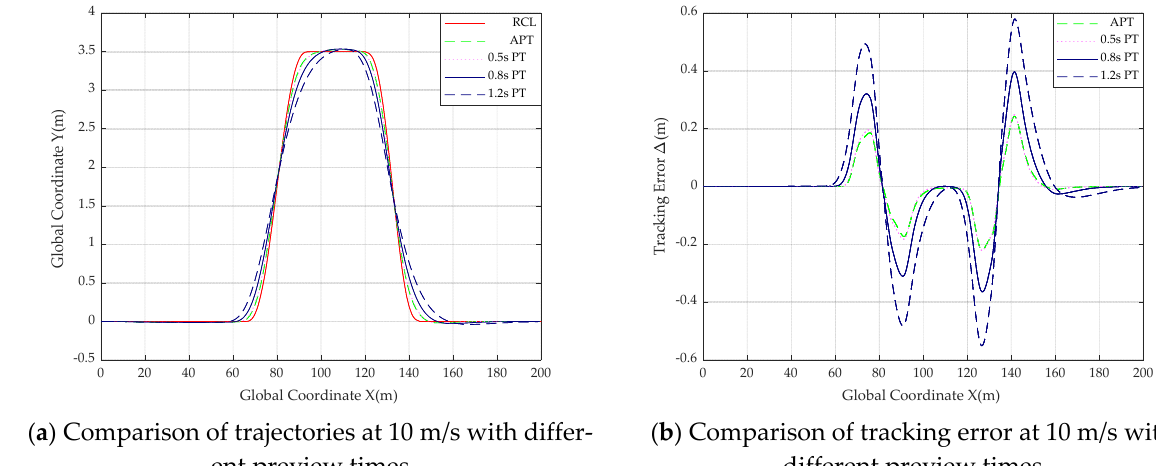
Figure 20. Comparison of trajectories and tracking error with different preview times at 10 m/s.